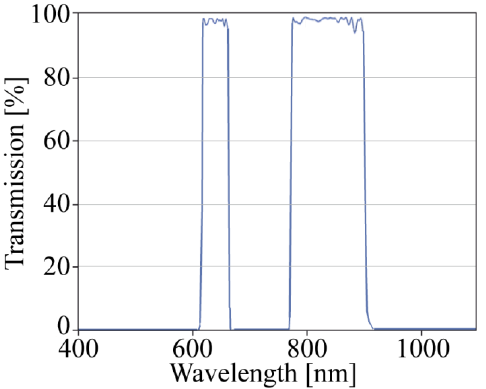
Figure 6. Filter design of the custom-made ET620_60 bp_780_900 bp dual band pass filter from Chroma.